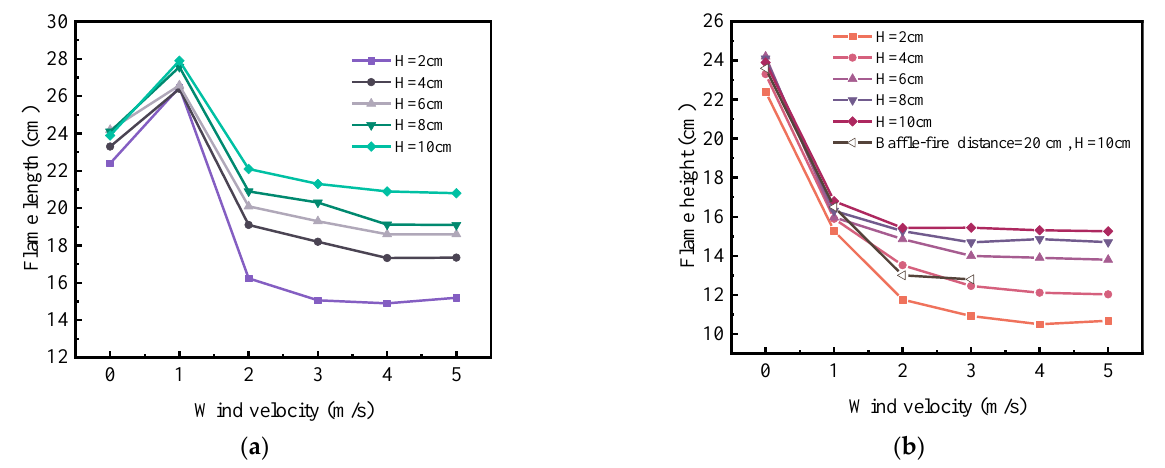
ing crosswinds. The flame height decreased with an increase in wind speed.